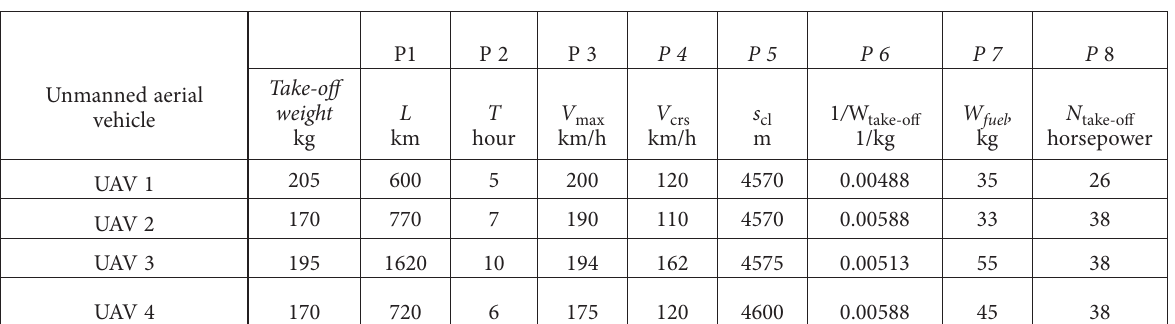
Priority Table 5. Flight characteristics of UAS